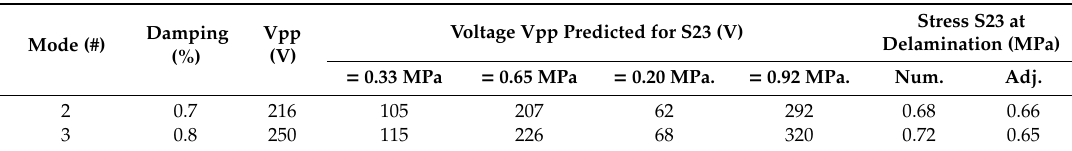
Table 16. Stress S23 and voltage prediction by the numerical model compared to experimental results for delamination modes.